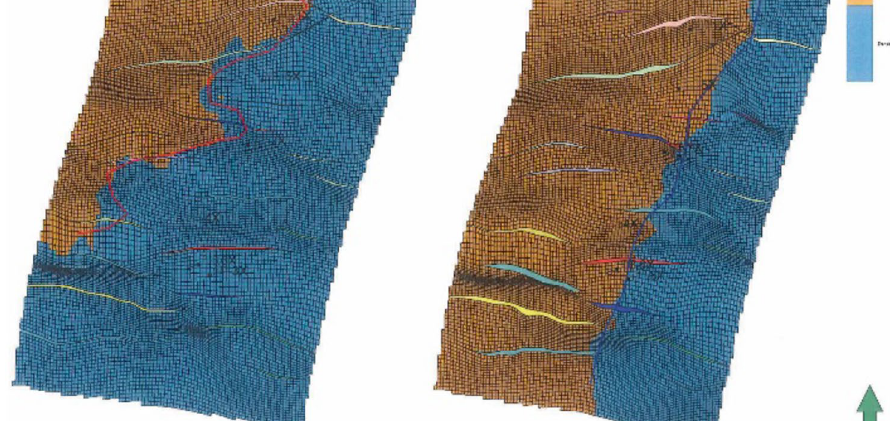
Fig. 20 Area division in top (left) and bottom (right) of C reservoir